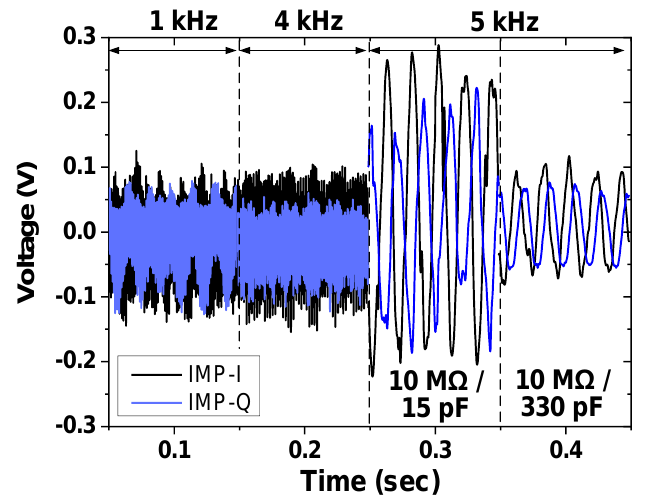
( b ) Figure 25. Measured range of the ETI system for ( a ) differential resistance and ( b ) differential ca- pacitance. The values of the injected current are also shown. Figure 26 shows the measured results of the BP channels using a gain of 43 dB, f CH = 2 kHz, and ∆ f = 50 Hz. The input cardiac signal having V pp = 20 mV is generated using a function generator. Figure 27 shows the measured waveforms of the ECG and IMP chan- nels. The electrodes attached to the wrists are connected to the current driver. A differen- tial current of 303 μA pp is injected into the electrode. Other sets of electrodes are connected between the body and test boards (AE and BE), thus amplifying the biopotential signal using 45 dB gain. The environmental noise is suppressed using a filtering function of the Keysight MSO-X oscilloscope. The motion artifact is induced by applying a hard push to the electrode. The result shows a successful operation of the proposed ETI system in vivo, where the ECG signals are measured while ETI is monitored. 10 0